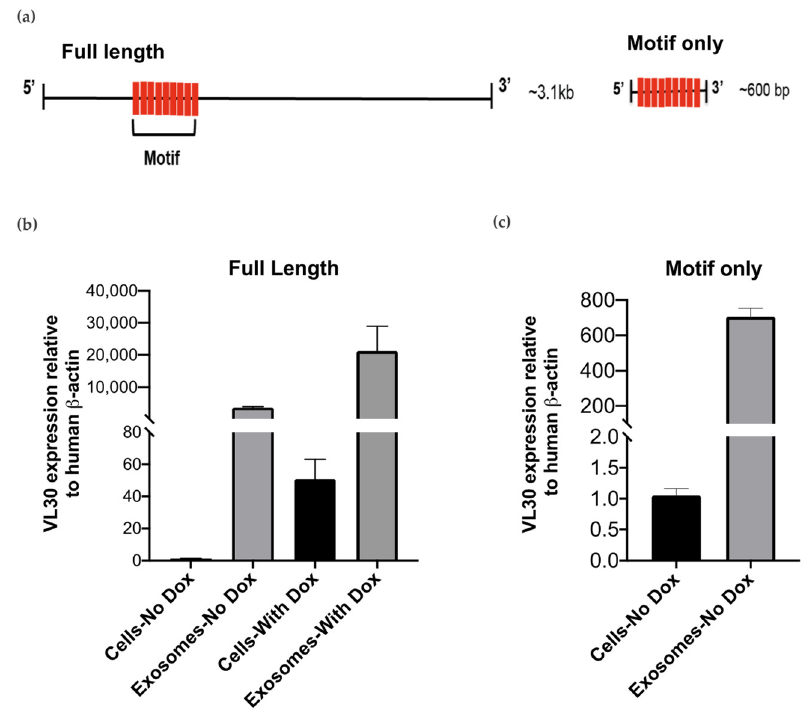
Figure 4. Full-length VL30 lncRNA and motif sequence were incorporated in SEVs of human neuronal cell line (SH-SY5Y). ( a ) Schematic representation of full length and motif-only VL30 constructs derived from the C730003K16 Riken clone. Both constructs contain nine tandem copies of the 26-bp motif sequence (red bar). ( b ) SH-SY5Y cells were transduced with a full length VL30 construct under the control of a doxycycline-inducible promoter. Abundance of VL30 RNA in both cells and SEVs ± doxycycline treatment was measured by qRT-PCR, and normalised to β –actin. Data shown are representative of two independent experiments. Error bars represent SEM. ( c ) SH-SY5Y cells were transduced with the motif-only VL30 construct under the control of a doxycycline-inducible promoter. Abundance of VL30 RNA in both cells and SEVs ± doxycycline treatment was measured by qRT-PCR, and normalised to β –actin. Data shown are representative of two independent experiments. Error bars represent SEM. Given widespread cell death following addition of doxycycline, only data obtained in the absence of doxycycline are shown for the cells transduced with motif alone.